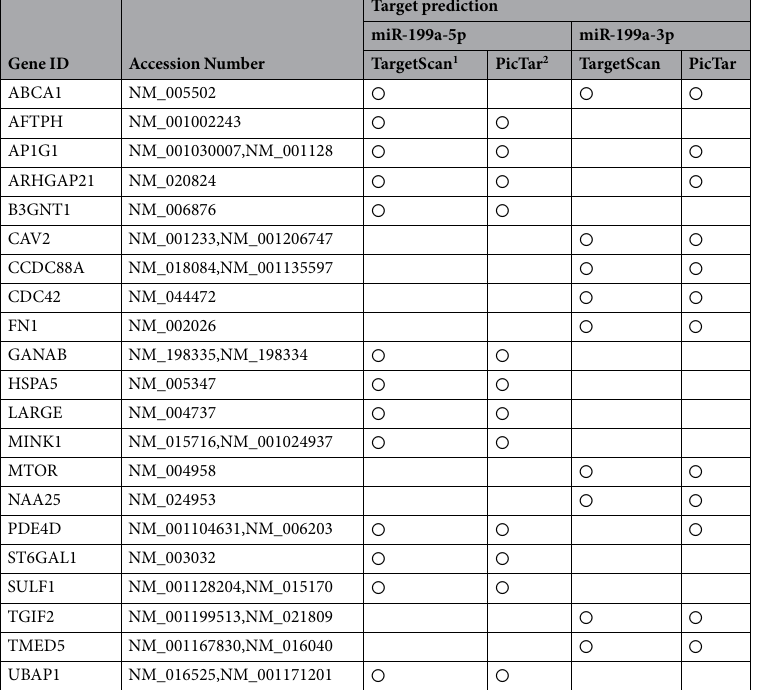
Table 1. Target identification using target prediction algorithms. 1 http://www.targetscan.org/. 2 http://pictar.